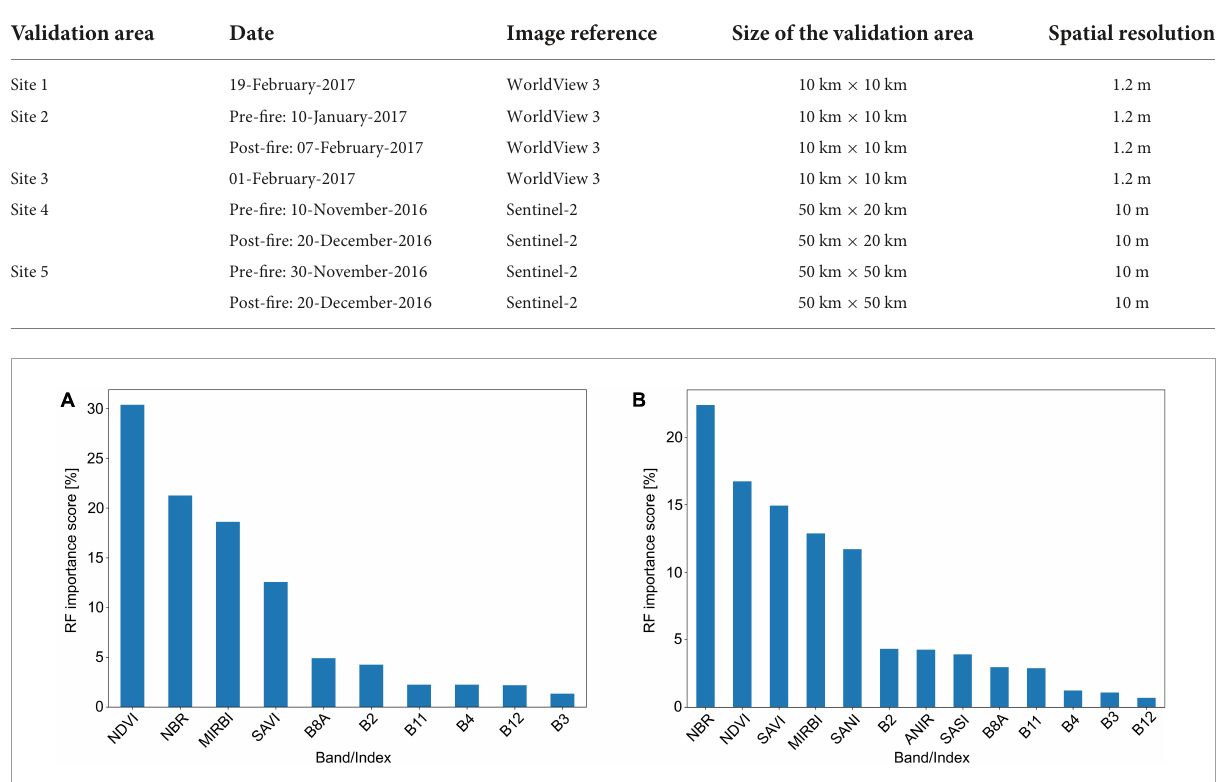
TABLE 2 Satellite data used to obtain the reference perimeters of burned area.